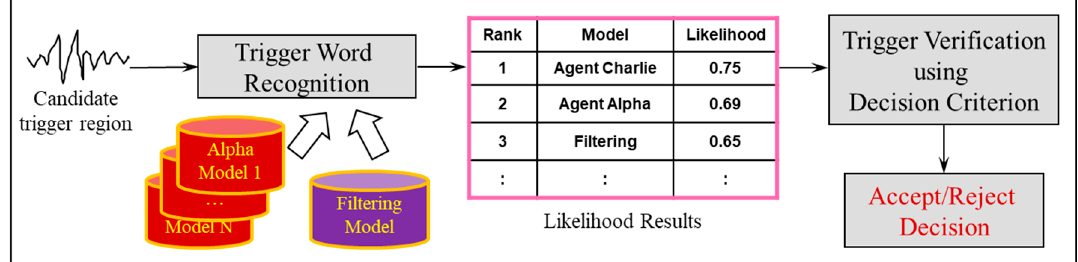
Figure 8. Procedure of proposed post-processing for trigger word verification.